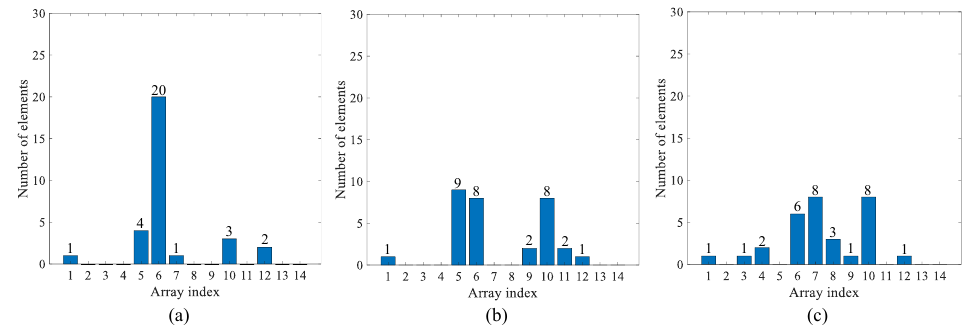
Figure 9. Example scenarios for counter array grouping strategy. ( a ) Single majority where one bucket has more than 20 elements. ( b ) Double majority where two adjacent buckets have the majority elements. ( c ) Triple majority where three adjacent buckets have the majority